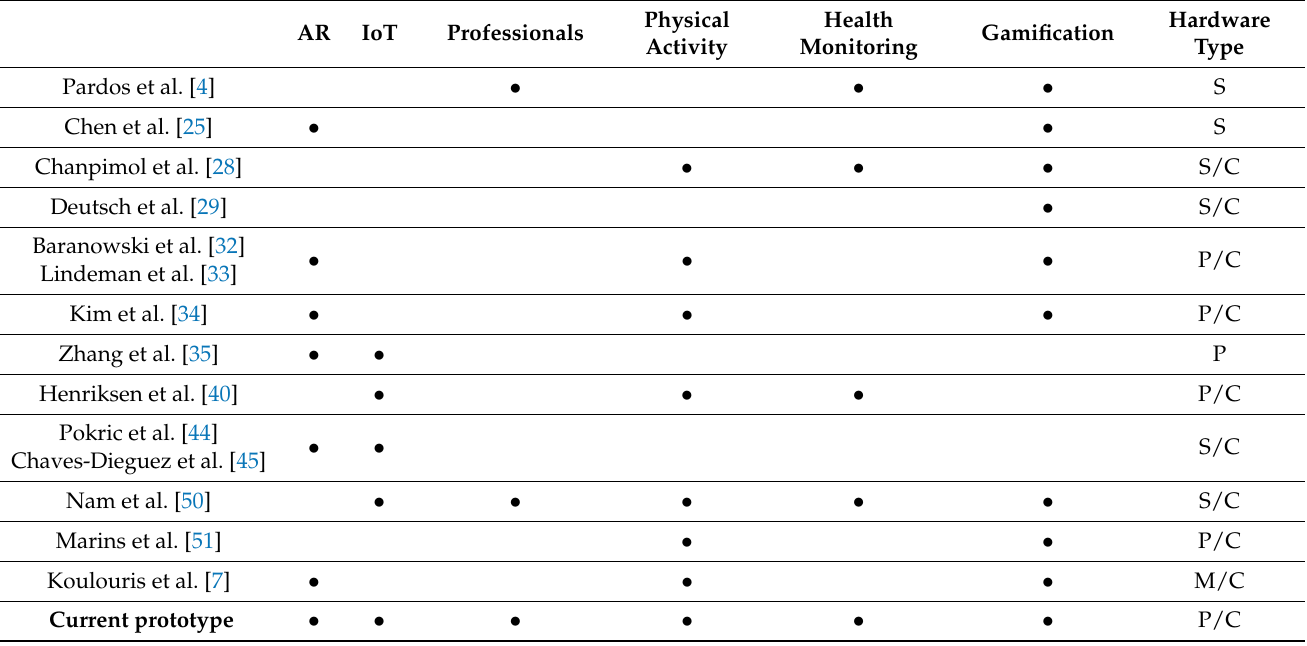
Table 8. Comparison of system’s capabilities with the